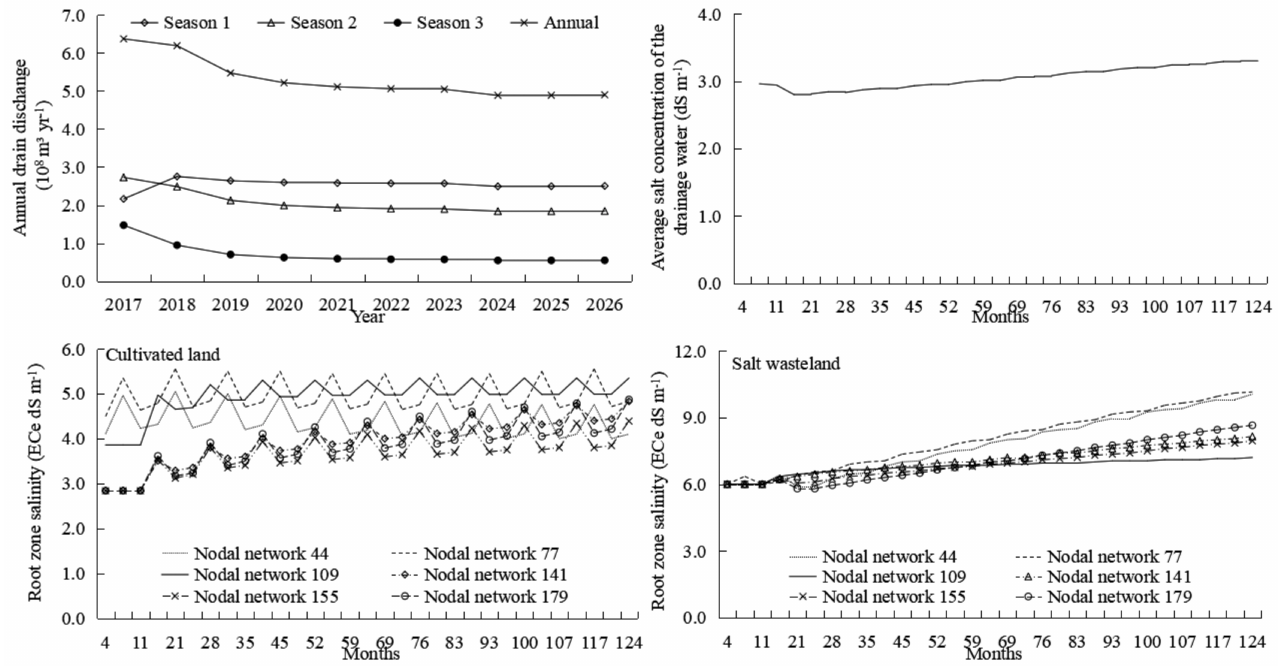
Figure 7. Changes in drainage quantity, drainage water salinity, soil salinity dynamics of cultivated land, and salt wasteland under the existing irrigation and drainage